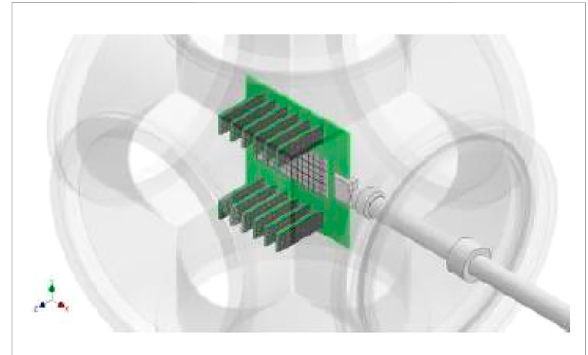
FIGURE 5 Sketch of the proposed detection system in its fi nal con fi guration. The system is housed in a DN160 spherical cross element along the beam path and can be moved out of the beam via a lateral arm.